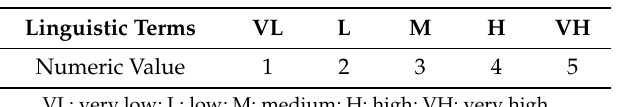
Table 1. Membership functions linguistic terms with weights.